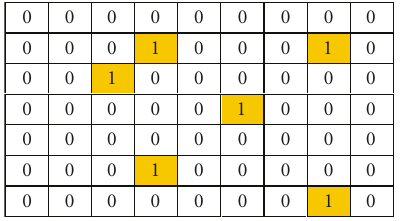
Figure 2: Window of interest of the observation binary image at time t